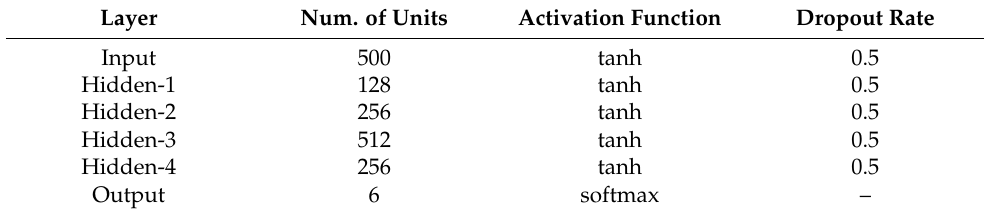
Table 5. Network structure and hyper parameters